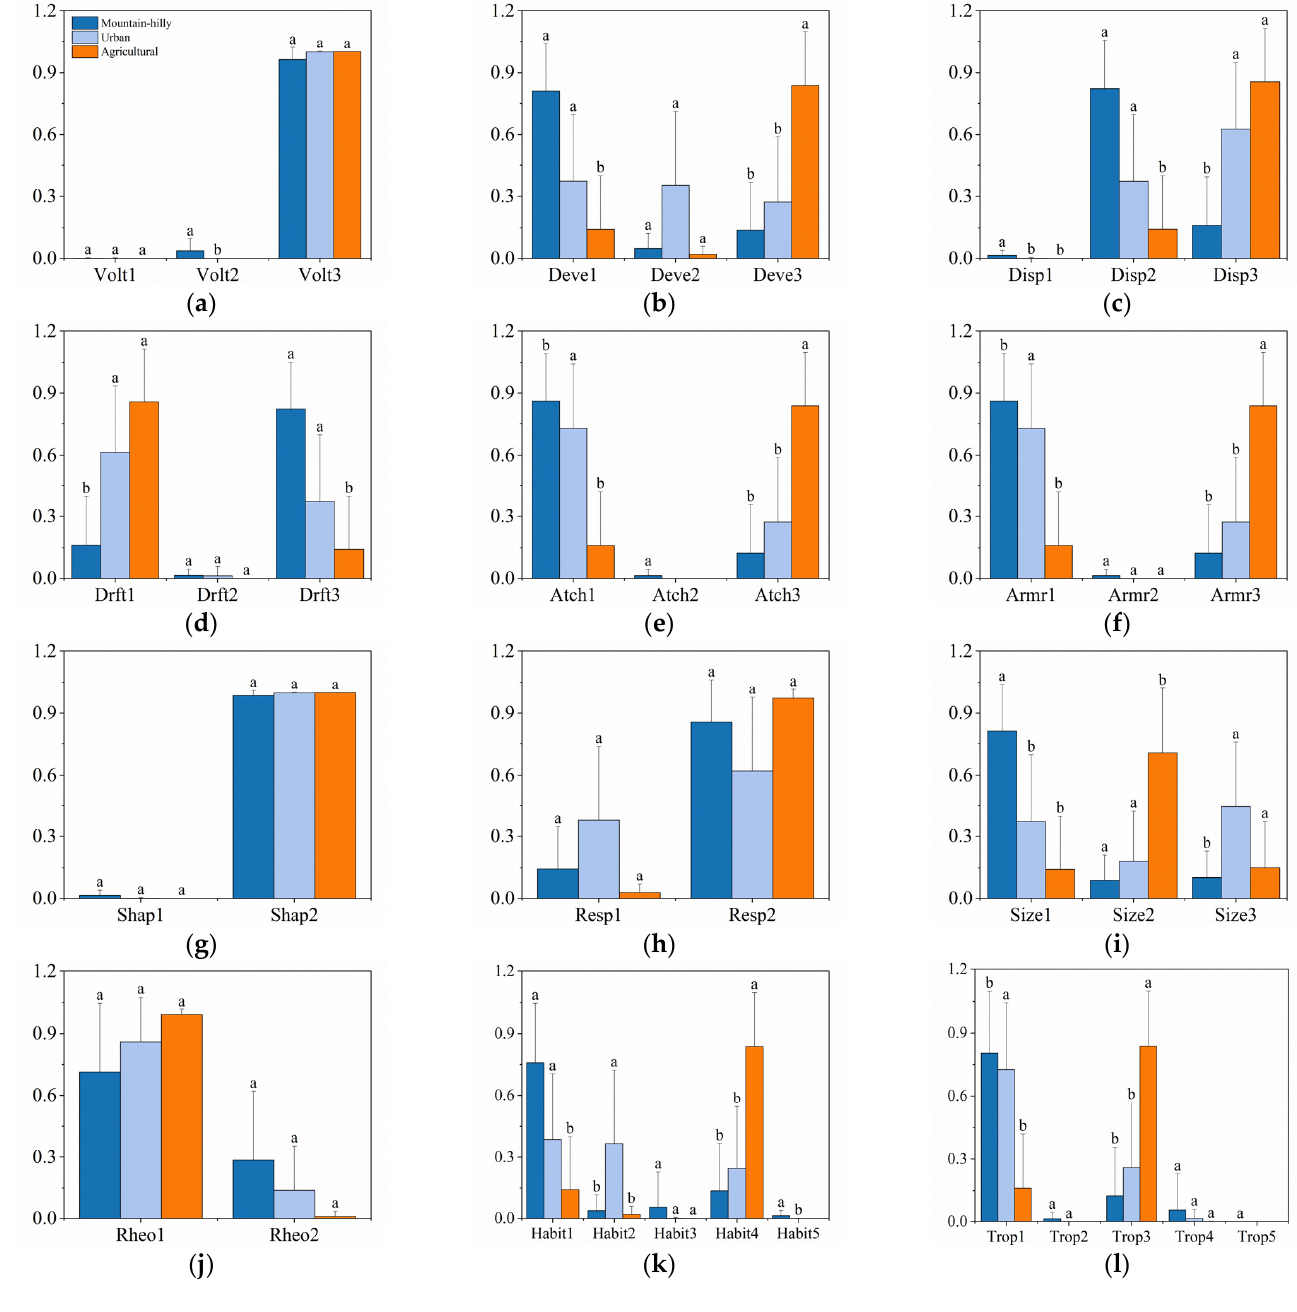
Figure 4. The structure of 36 categories of eleven traits at three land use types. Each bar represents the mean percentage with standard deviation of each trait category. ( a ) The trait of voltinism in different land use types; ( b ) the trait of development in different land use types; ( c ) the trait of dispersal in different land use types; ( d ) the trait of drift in different land use types; ( e ) the trait of attachment in different land use types; ( f ) the trait of armoring in different land use types; ( g ) the trait of shape in different land use types; ( h ) the trait of respiration in different land use types; ( i ) the trait of size in different land use types; ( j ) the trait of rheophily in different land use types; ( k ) the trait of habit in different land use types; ( l ) the trait of trophic habit in different land use types. Various letters denote the significant differences according to Kruskal-Wallis test at a 0.05 probability level.